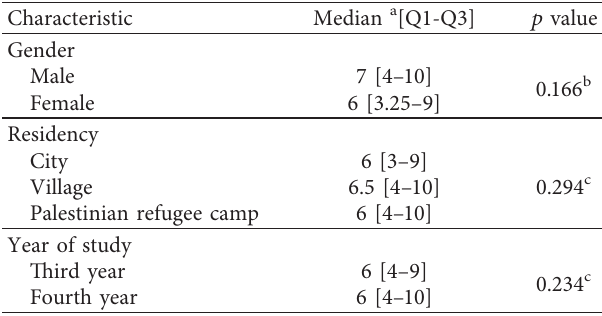
Table 14: Association between nursing students’ demographic characteristics and attitude